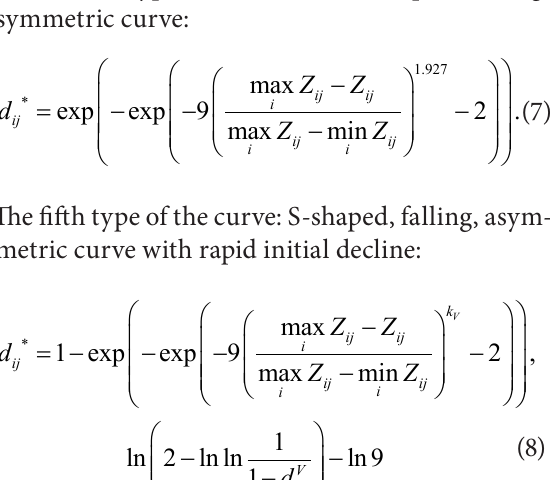
Table 1. Quantitative and qualitative interpretation of the information security